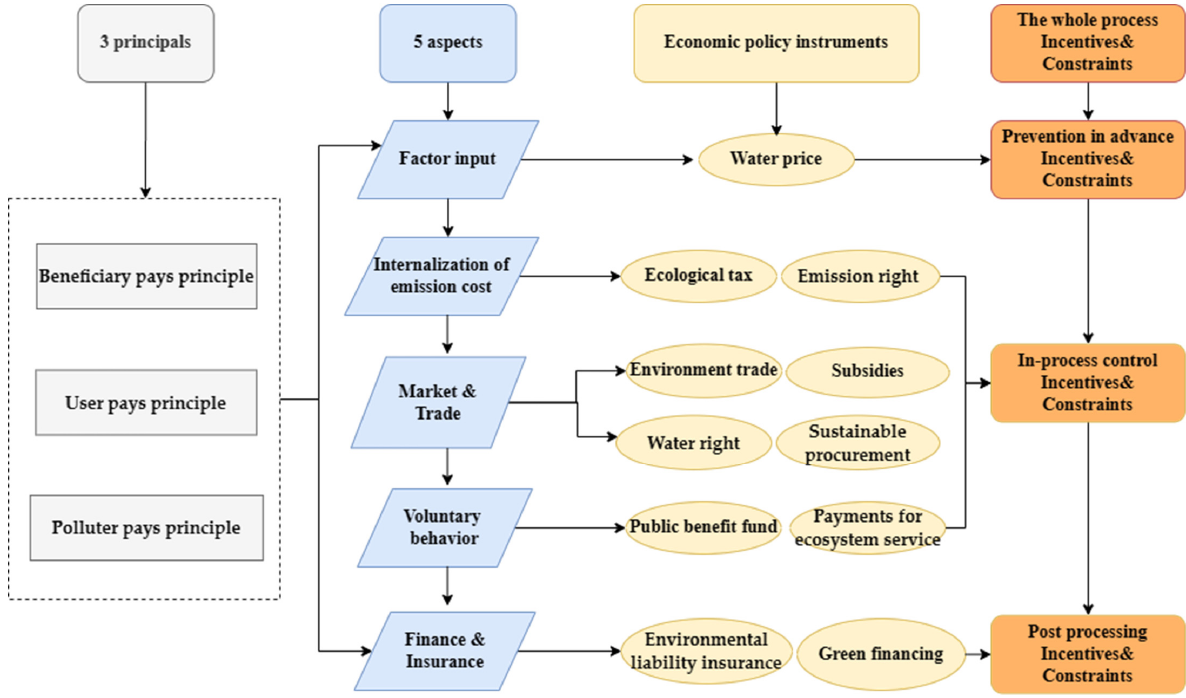
Figure 4. The EPI system outlook of DWP in China.